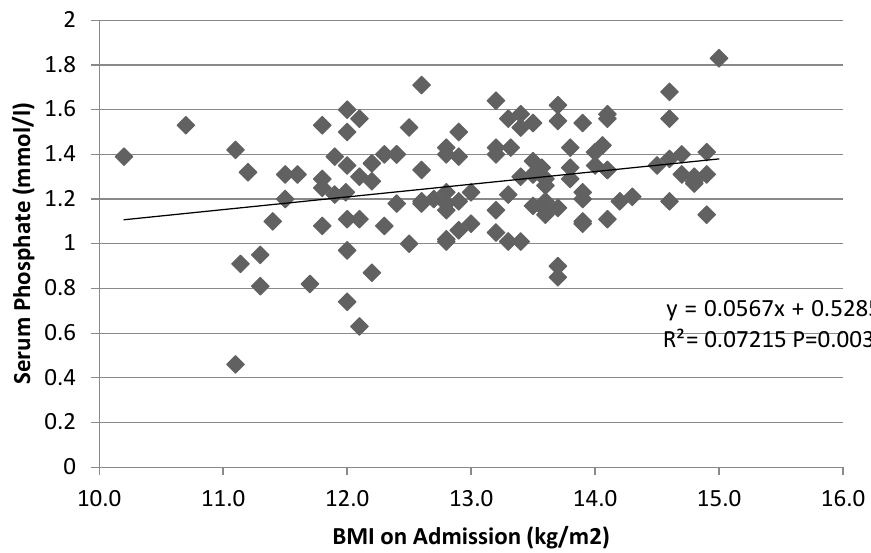
Figure 2. Relationship between serum phosphate and BMI on admission. While the correlation was significant, R 2 was very low (r 2 = 0.07), indicating only a weak relationship between the two factors. Patients with a lower BMI on admission tended to have lower serum phosphate values. However, the patient with the lowest BMI of 10.2 had normal serum phosphate values of 1.32 mmol/L, whereas a patient with a BMI of 13.7 presented with a phosphate value of 0.9 mmol/L. Moreover, the BMI of patients with hypophosphatemia in this study ranged from 11.1 to 13.7 kg/m 2 , indicating that low phosphate values are not necessarily exhibited only at lower BMI values.